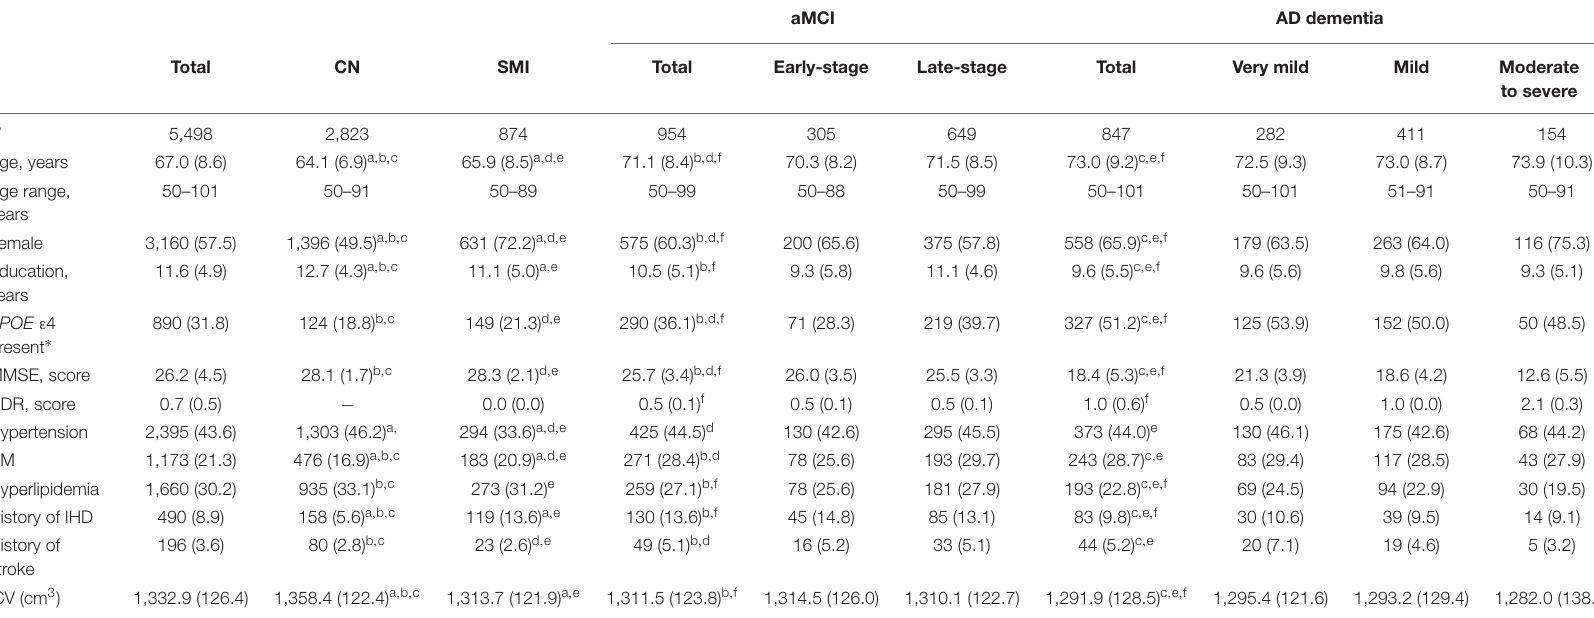
TABLE 1 | Demographic and clinical characteristics of the study participants ( N =